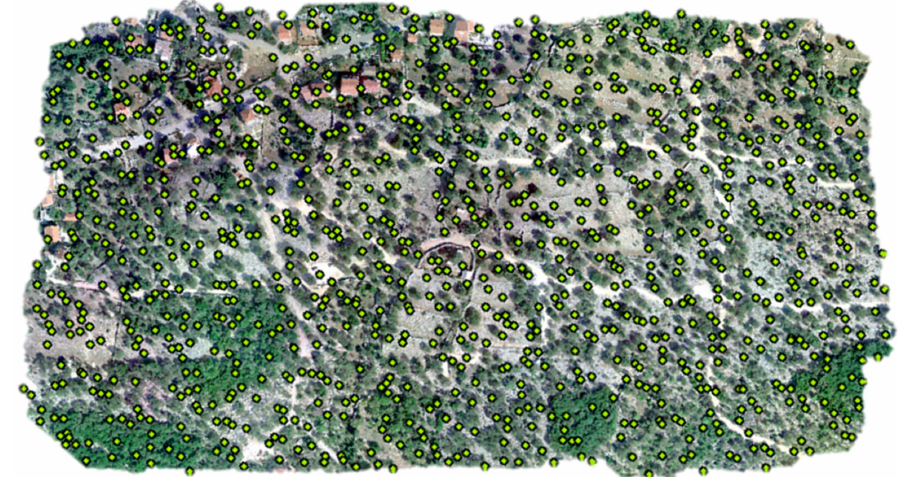
Figure 9. Thousand randomly distributed accuracy assessment